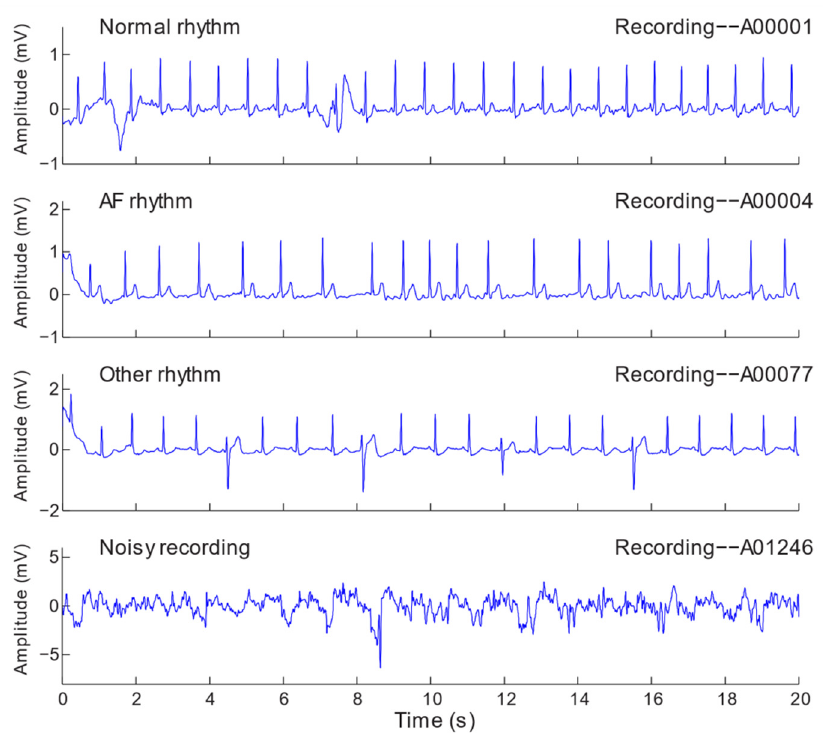
Figure 4. ECG examples of four classes: Normal, AF, Other, and Noisy.